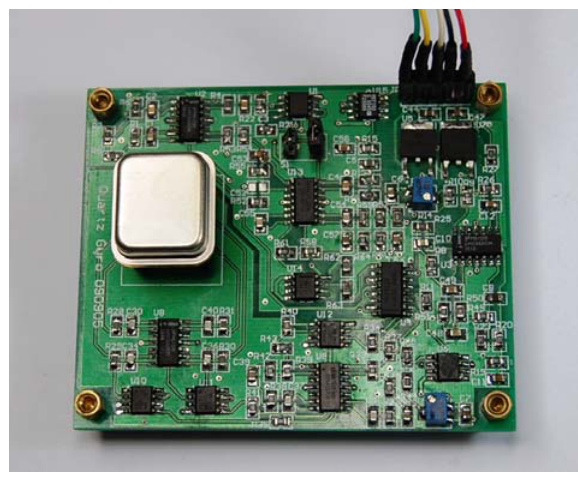
Figure 13. The photo of the readout